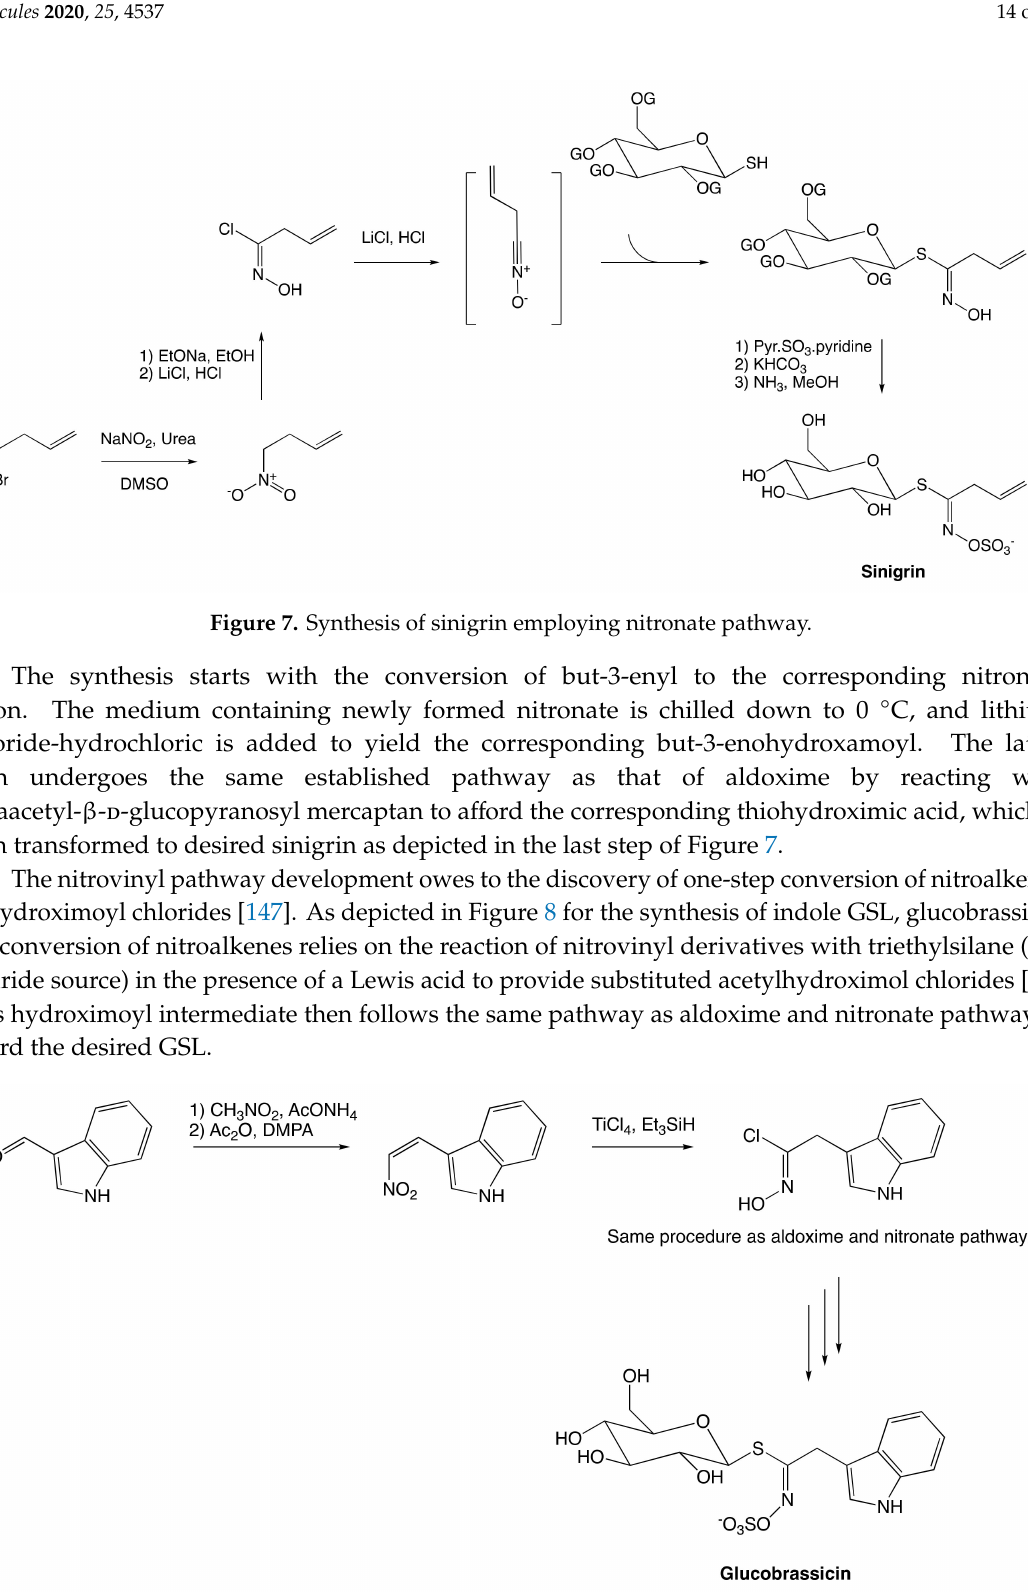
Figure 8. Synthesis of